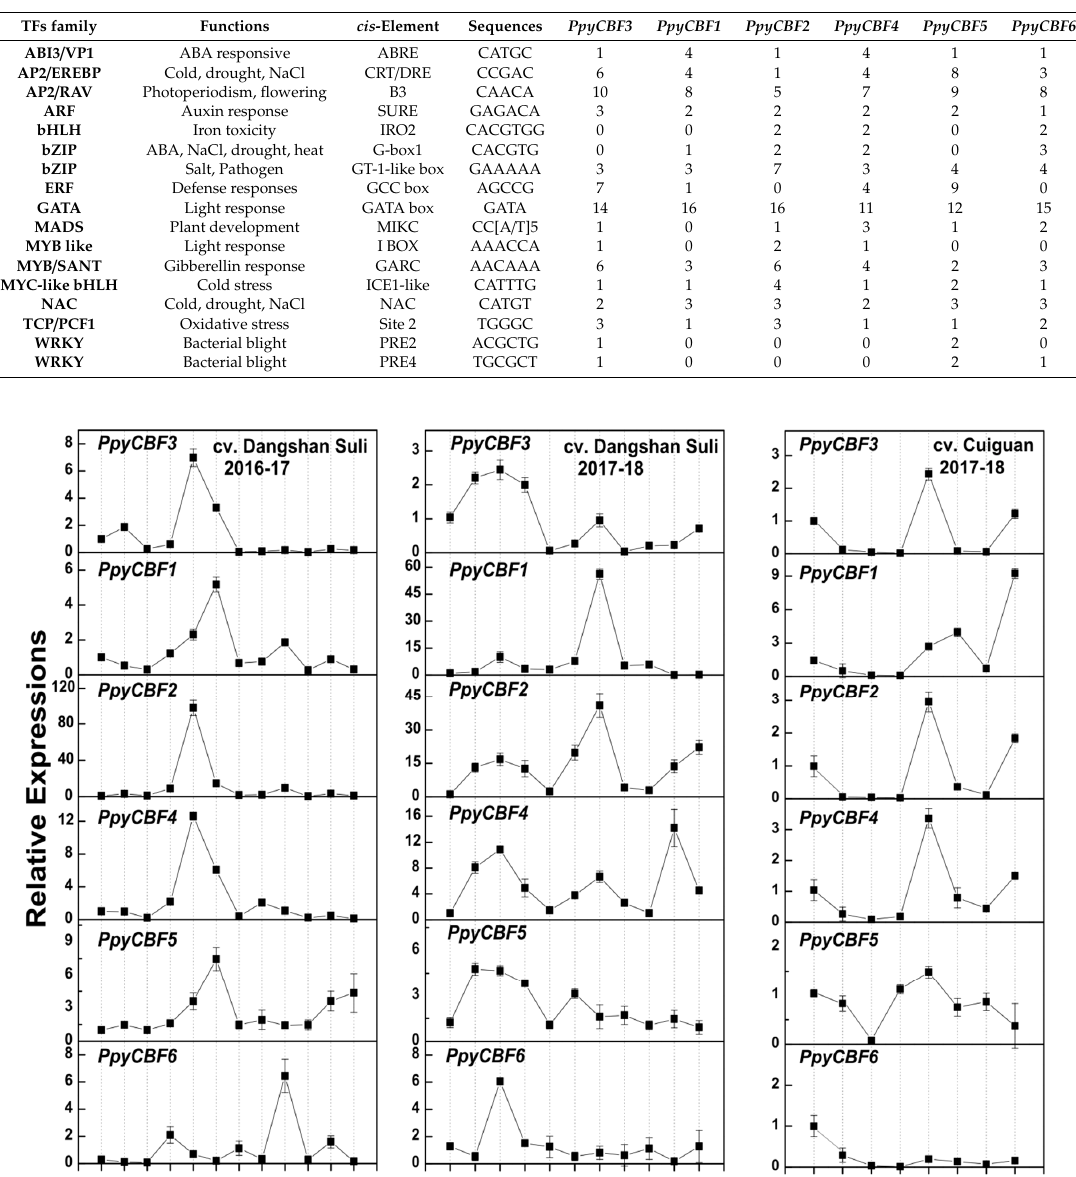
Table 1. Promoter analysis of all isolated PpyCBFs .